Question: What visual encoding does this figure use to show its data?
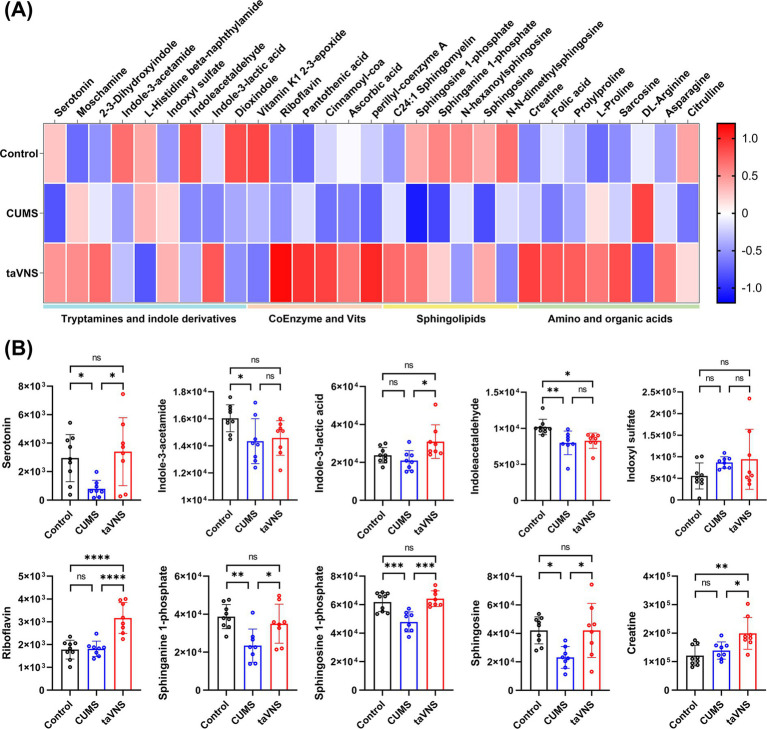
Answer: heatmap